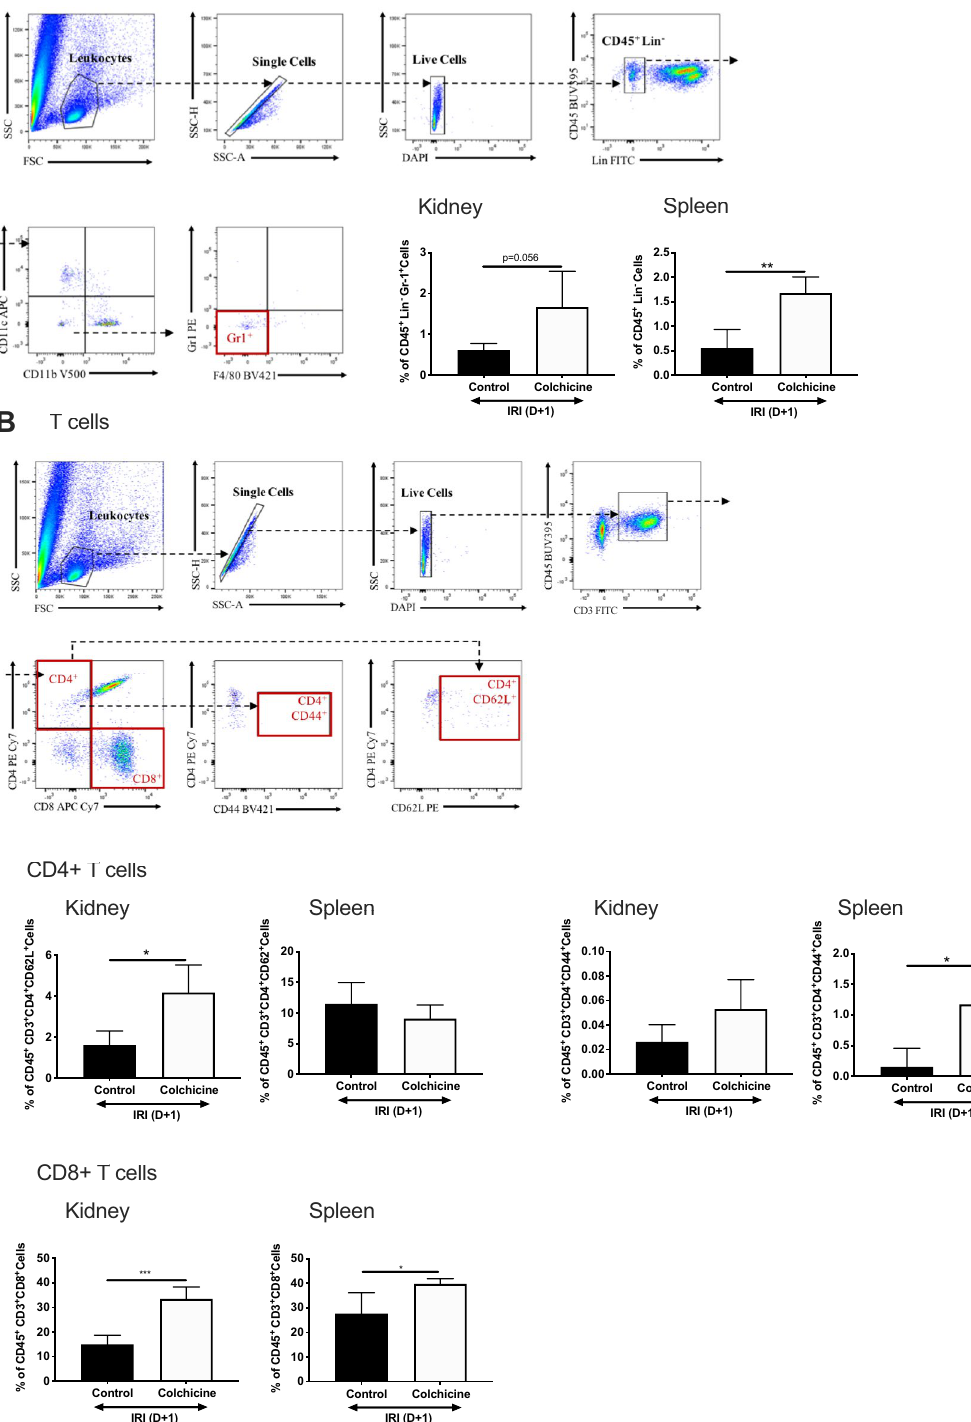
Figure 4. Colchicine increases the inflammatory cell infiltrate within the renal parenchyma. Age-matched male C57BL/6 mice were administered vehicle control (phosphate buffered saline, PBS) or colchicine, and then subjected to bilateral renal ischemia followed by 24 h reperfusion. Kidney and spleen were digested using collagenase, and leukocytes separated from parenchymal cells using CD45 + MACS beads. Cells were counted, then stained according to the fluorescence panel required. Gating strategies are shown for each panel, and proportions of cell populations were calculated for ( A ) neutrophils, ( B ) CD4 + CD62L + (naïve) T cells , ( C ) CD4 + CD44 + (activated) T cells, ( D ) CD8 + T cells, ( E ) CD11c + CD103 + DC and ( F ) CD11b + F4/80 + CD11c- macrophages are shown. ( F ) Mean fluorescence intensity (MFI) of cell-surface maturation markers CD80, CD86, CD40, MHC and PDL1 on CD11c + DC isolated from whole kidney. Results are presented as mean ± SD from n = 3 independent experiments, each with n = 2 mice per experiment, * p < 0.05, ** p < 0.01, *** p <